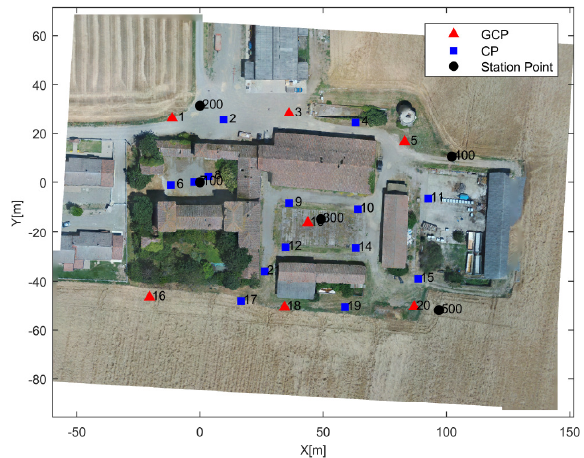
Figure 1. Surveyed area and geodetic network scheme Among them, 7 targets have been used as Ground Control Points (GCPs) (6 of them located outside the castle and one located in the middle of the main courtyard). The other points have been used as Check Points (CPs), guaranteeing the independence of the measurements. The coordinates of two station points were measured with a GNSS receiver, in order to georeference the network in the ETRF2000(08) global reference frame. Finally, the geodetic network has been transformed in a local reference system, with origin in the point 100, Z-axis along the vertical direction and Y-axis orientated along the direction defined by the points 100 and